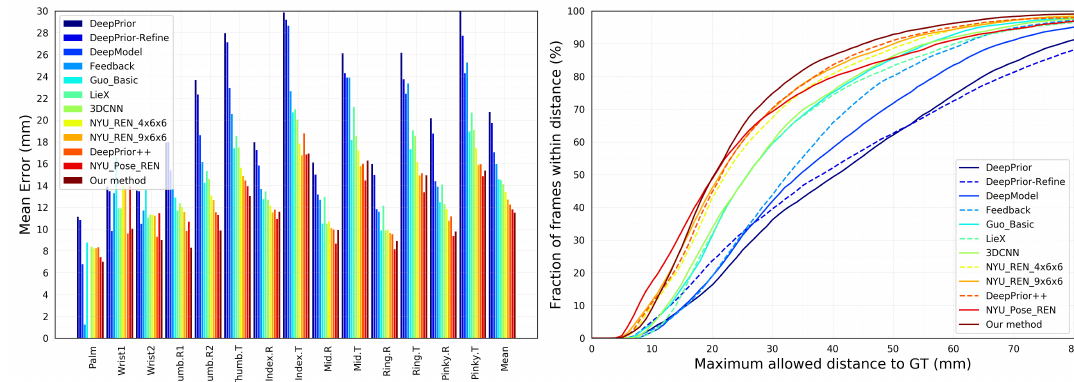
Figure 2. Our approach compares the latest benchmarks on NYU dataset. Left : Each joint error. Right : The fraction of frames over different maximum Euclidean distance error thresholds. The large area below the curve indicates better results. Our proposed method performs best in the graph of discriminating methods. (Best viewed on screen).